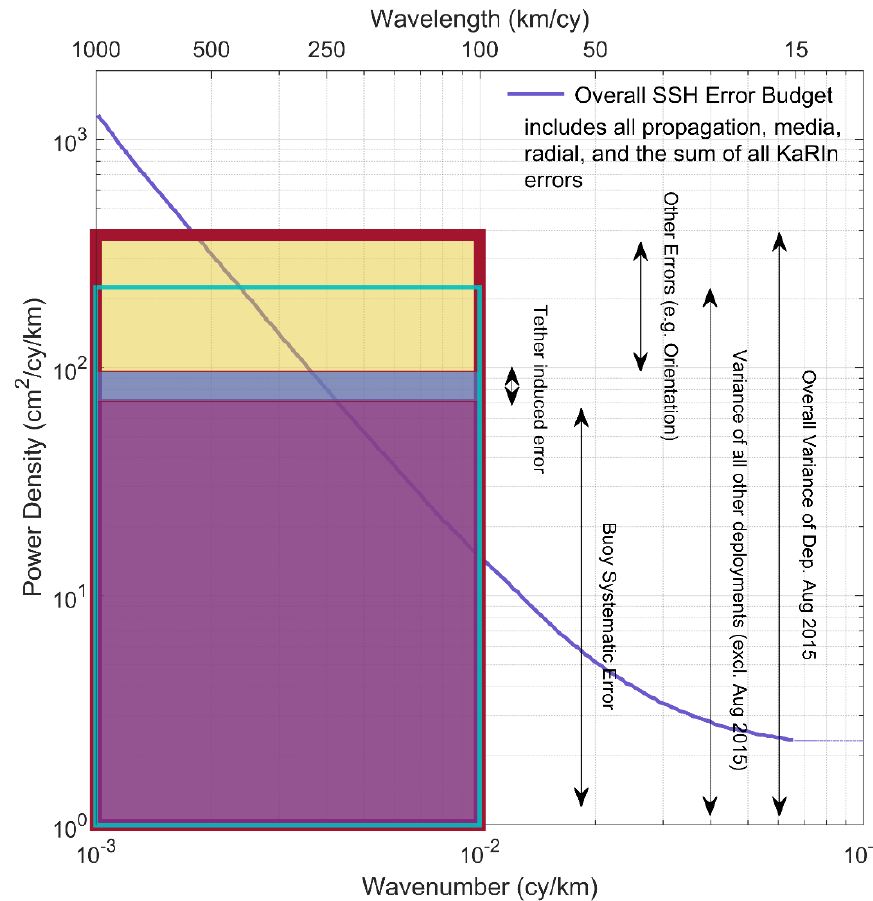
Figure 9. SWOT wave-number spectrum requirement with buoy deployment derived error sources mapped arbitrarily to the 100 km wavelength.